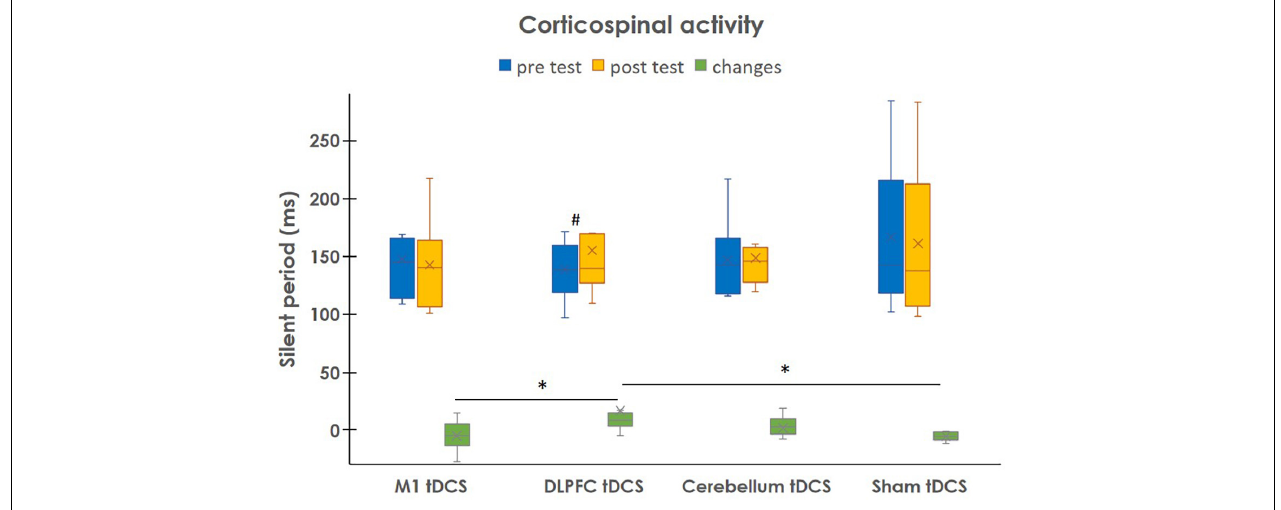
FIGURE 3 | Changes in silent period of ipsilateral hemisphere relatively to the stimulating side after different tDCS stimulations. Data are presented as the median (interquartile range). # P < 0.05: intragroup comparison. * P < 0.05: intergroup